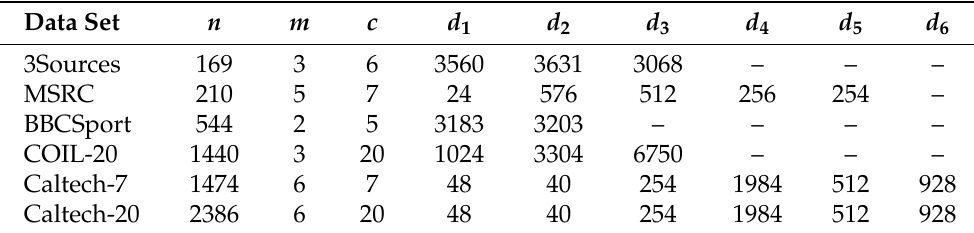
Table 2. Characteristics of all